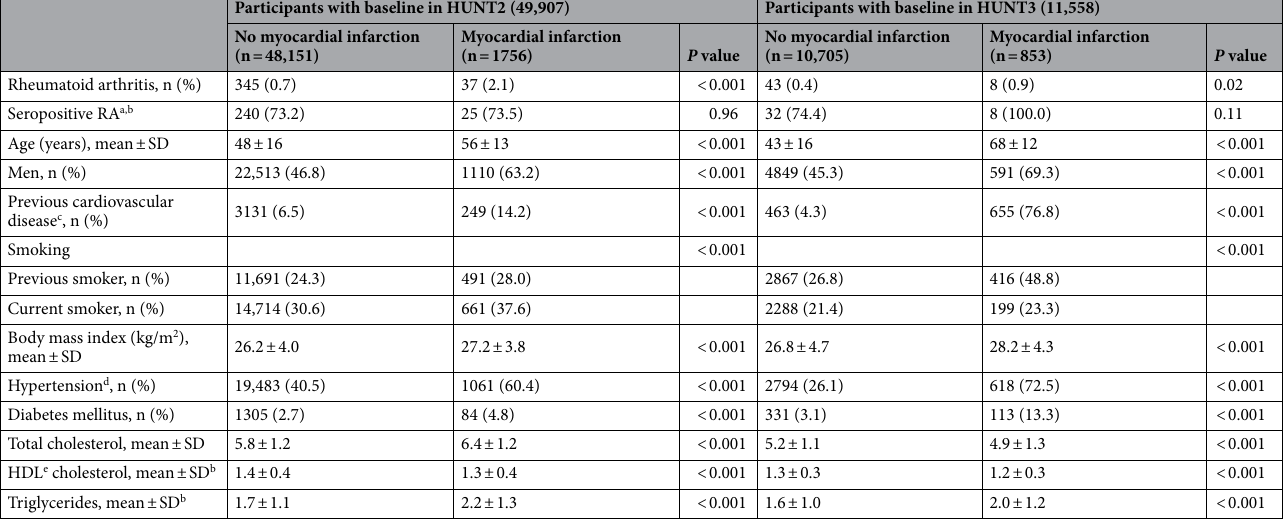
Table 1. Baseline characteristics of study participants. Number of participants: 61,465. Number of MI cases: 2609, as indicated for final dataset (Fig. 1). a Data missing for 20 observations at HUNT2 for RA seropositive; 18 observations at HUNT2, and 1 observation at HUNT3 for HDL cholesterol; 1 observation at HUNT2, and 1781 observation at HUNT3 for triglycerides. b Seropositive RA: Positive for rheumatoid factor and/or anti- citrullinated protein antibody. c Previous cardiovascular disease: Self-reported myocardial infarction, angina pectoris or stroke. d Hypertension (defined as a “yes” if systolic blood pressure ≥ 140 mmHg and/or diastolic blood pressure ≥ 90 mmHg, or self-reported usage of medication for high blood pressure). e HDL: high density